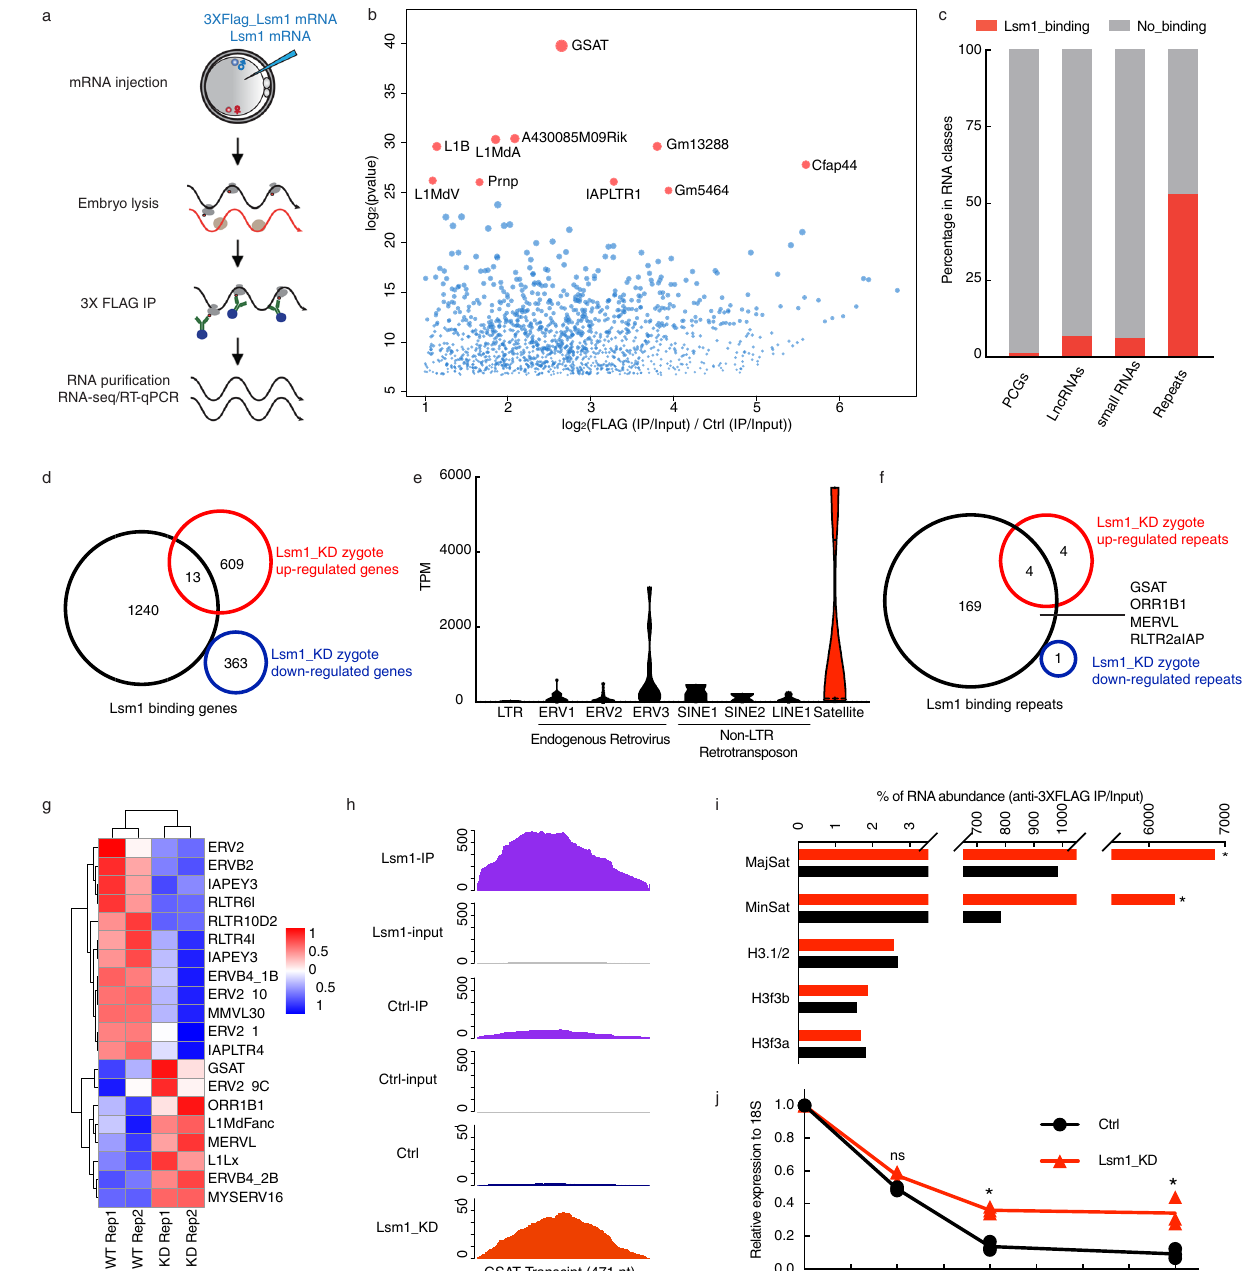
Fig. 3 | LSM1 interacts with major satellite RNA and regulates its decay. a SchemefortheLSM1RIP-seqandRIP-qPCRexperiments. b Volcanoplotshowing LSM1-bindingRNAsinzygotes.Thereddotsrepresentthetop10targetsofLSM1in zygotes. p -values (two-sided) attained by the Wald test are corrected for multiple testing using the Benjamini and Hochberg method by default ( n =2 biologically independent samples). c Bar graph showing the LSM1 binding ratios in different RNAclasses. d VenndiagramsshowingtheoverlapofLSM1-bindingprotein-coding genesandup-/downregulatedgenesinLsm1_KDzygotes. e Violinplotshowingthe distribution of LSM1-binding reads in different repeat families. f Venn diagrams showing the overlap of LSM1-binding repeats and up-/downregulated repeats in Lsm1_KD zygotes. g Heatmap showing differentially expressed repeats between Ctrl and Lsm1_KD zygotes. h Genome browser tracks showing LSM1 RIP-seq peaks